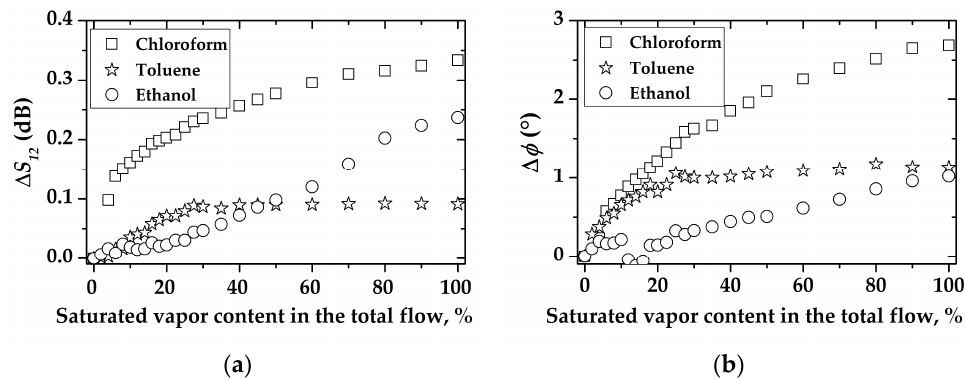
Figure 18. The changes in the positions of the extrema from Figure 16 for ( a ) S 12 parameter and ( b ) phase φ , versus different gases concentrations for device #1.